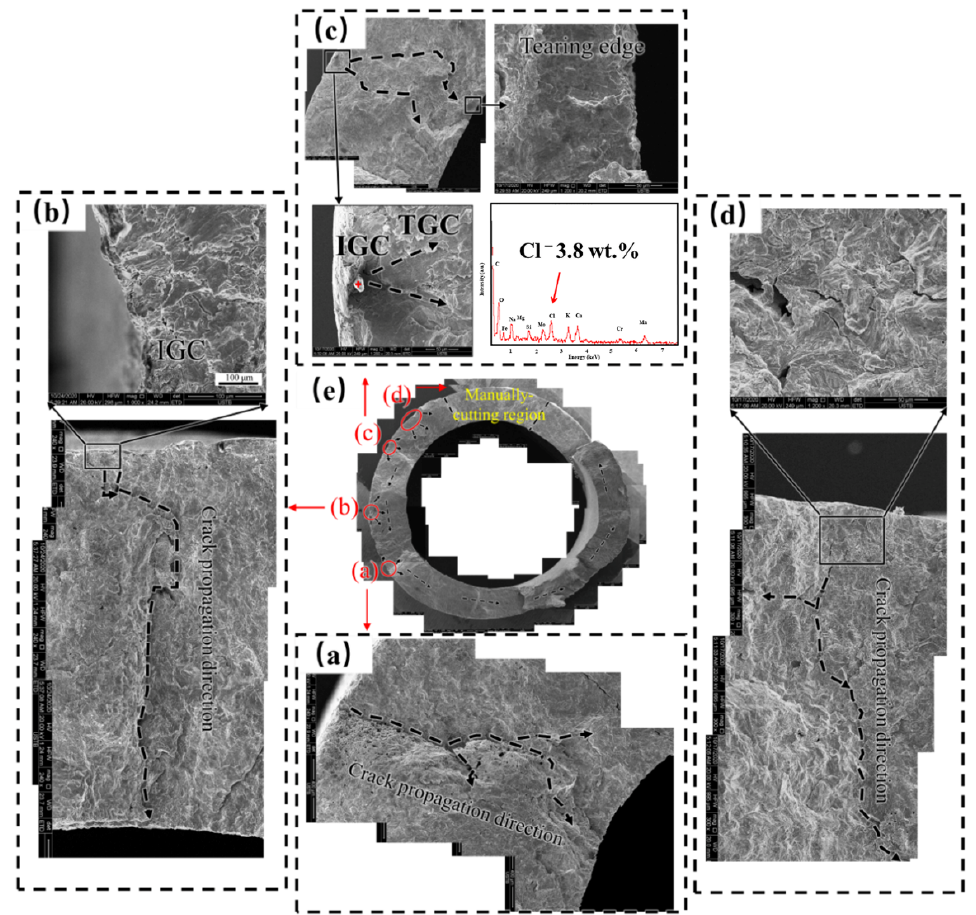
Figure 7. Fracture morphology in the main fracture. Four crack origins are shown in enlarged views in ( a – d ), and the fracture surface is shown in ( e ).